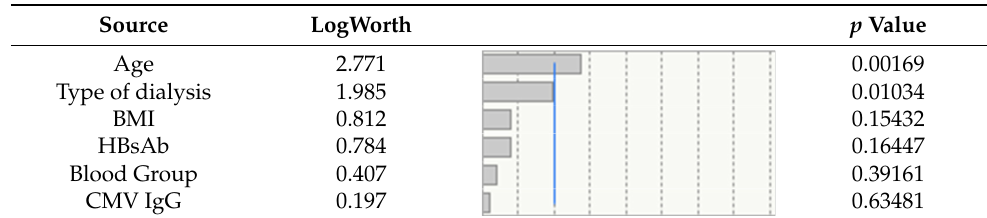
Table 4. Multiple regression for Antibodies Number.